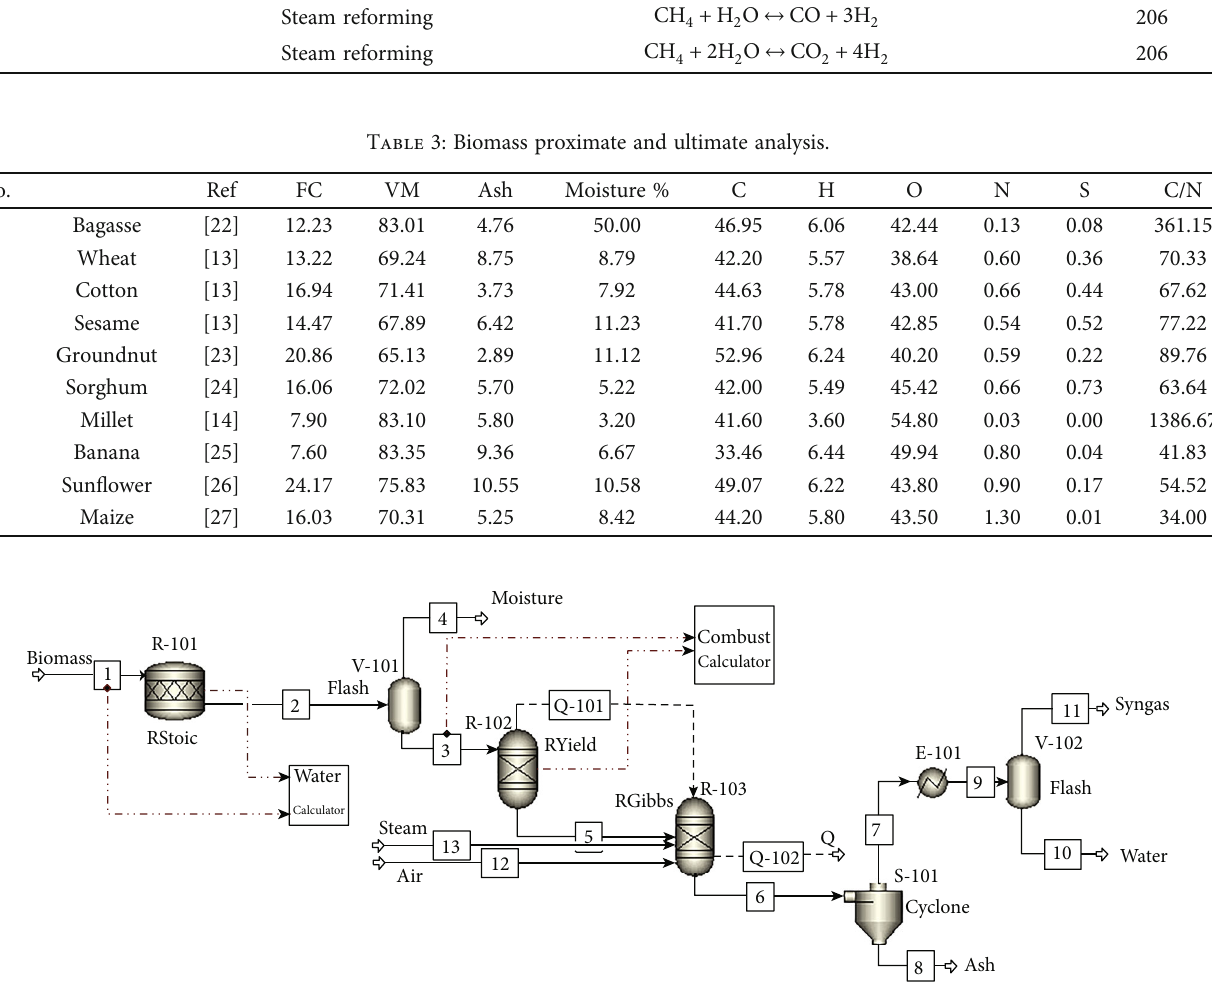
Figure 1: PFD of biomass gasi fi